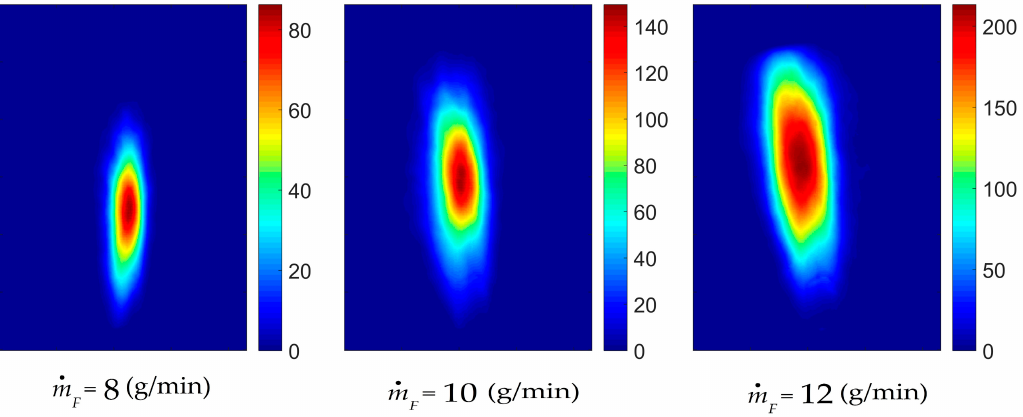
Figure 4. The distribution of mean value for the mass flow rate of fuel.